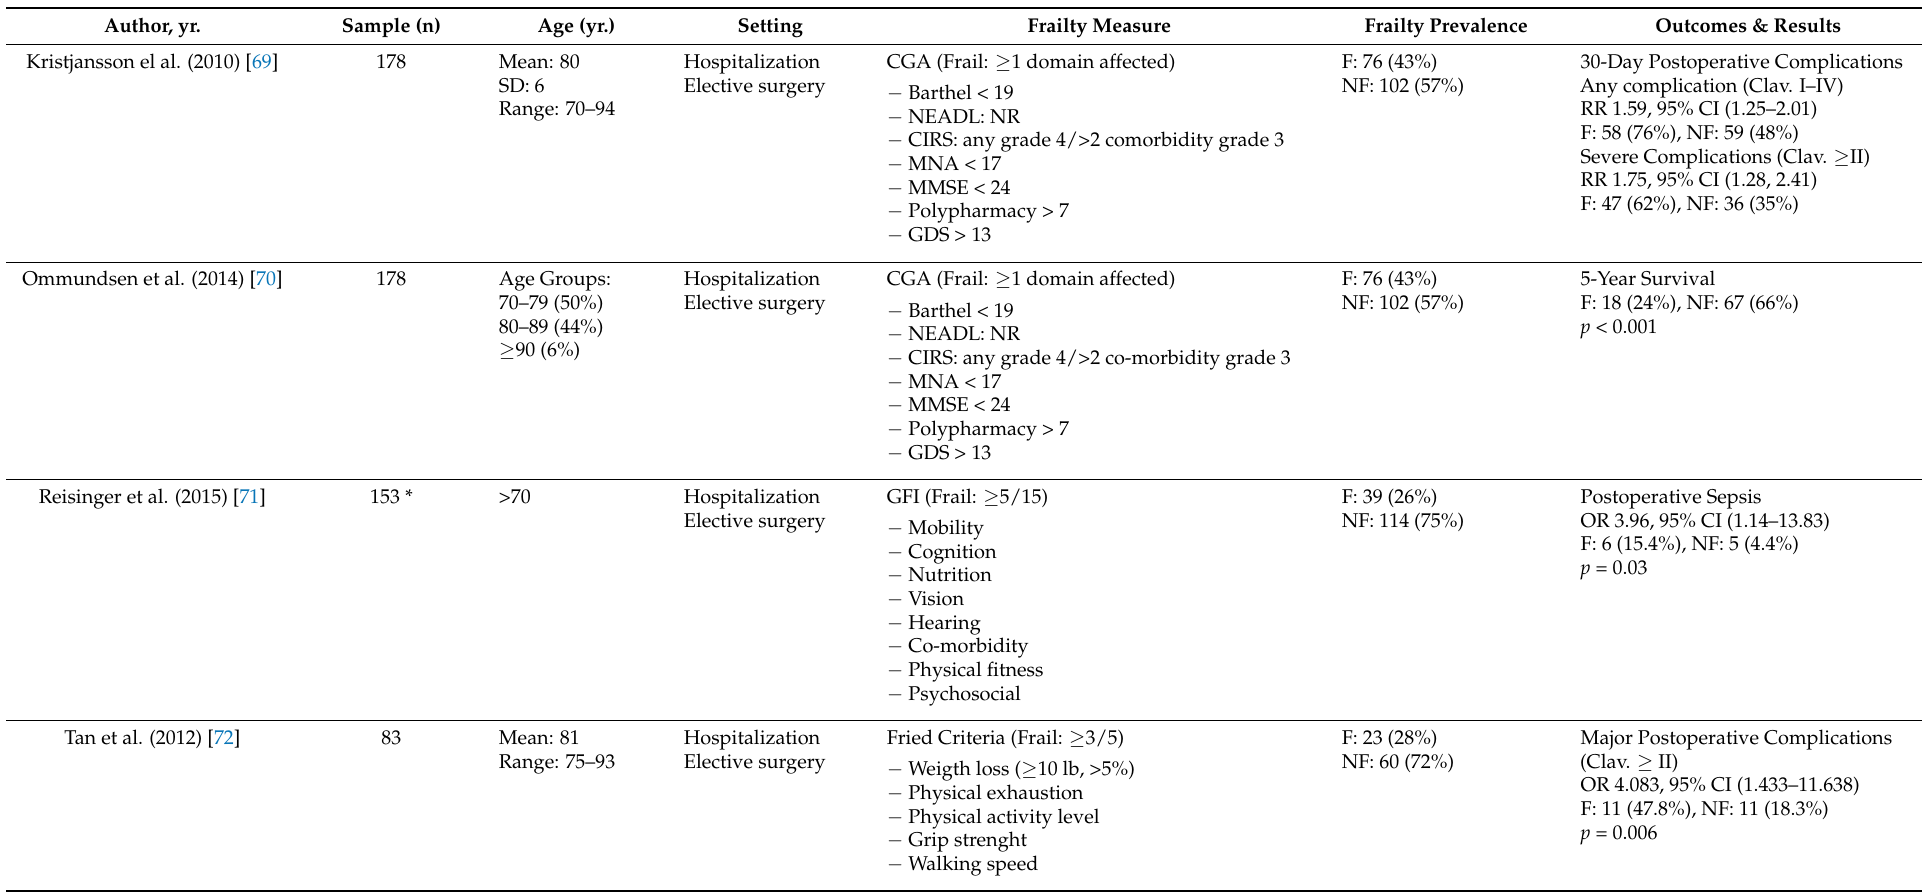
Table 1. Summary of studies in which the influence of frailty on post-operative outcomes in colorectal cancer populations was